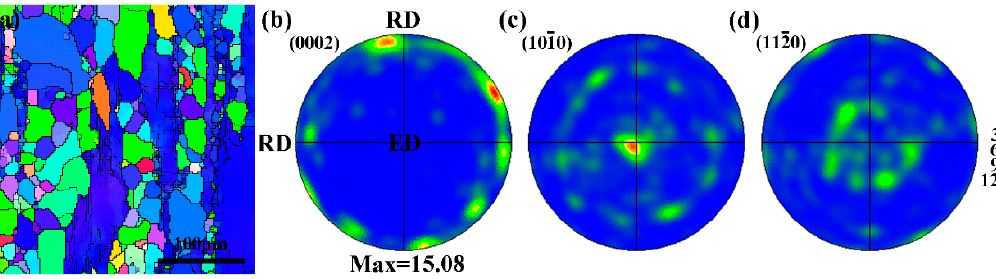
Figure 2. ( a ) Electron back scattering diffraction (EBSD) map and ( b ) (0002), ( c ) (10 figures of original AZ31 magnesium alloy rod.